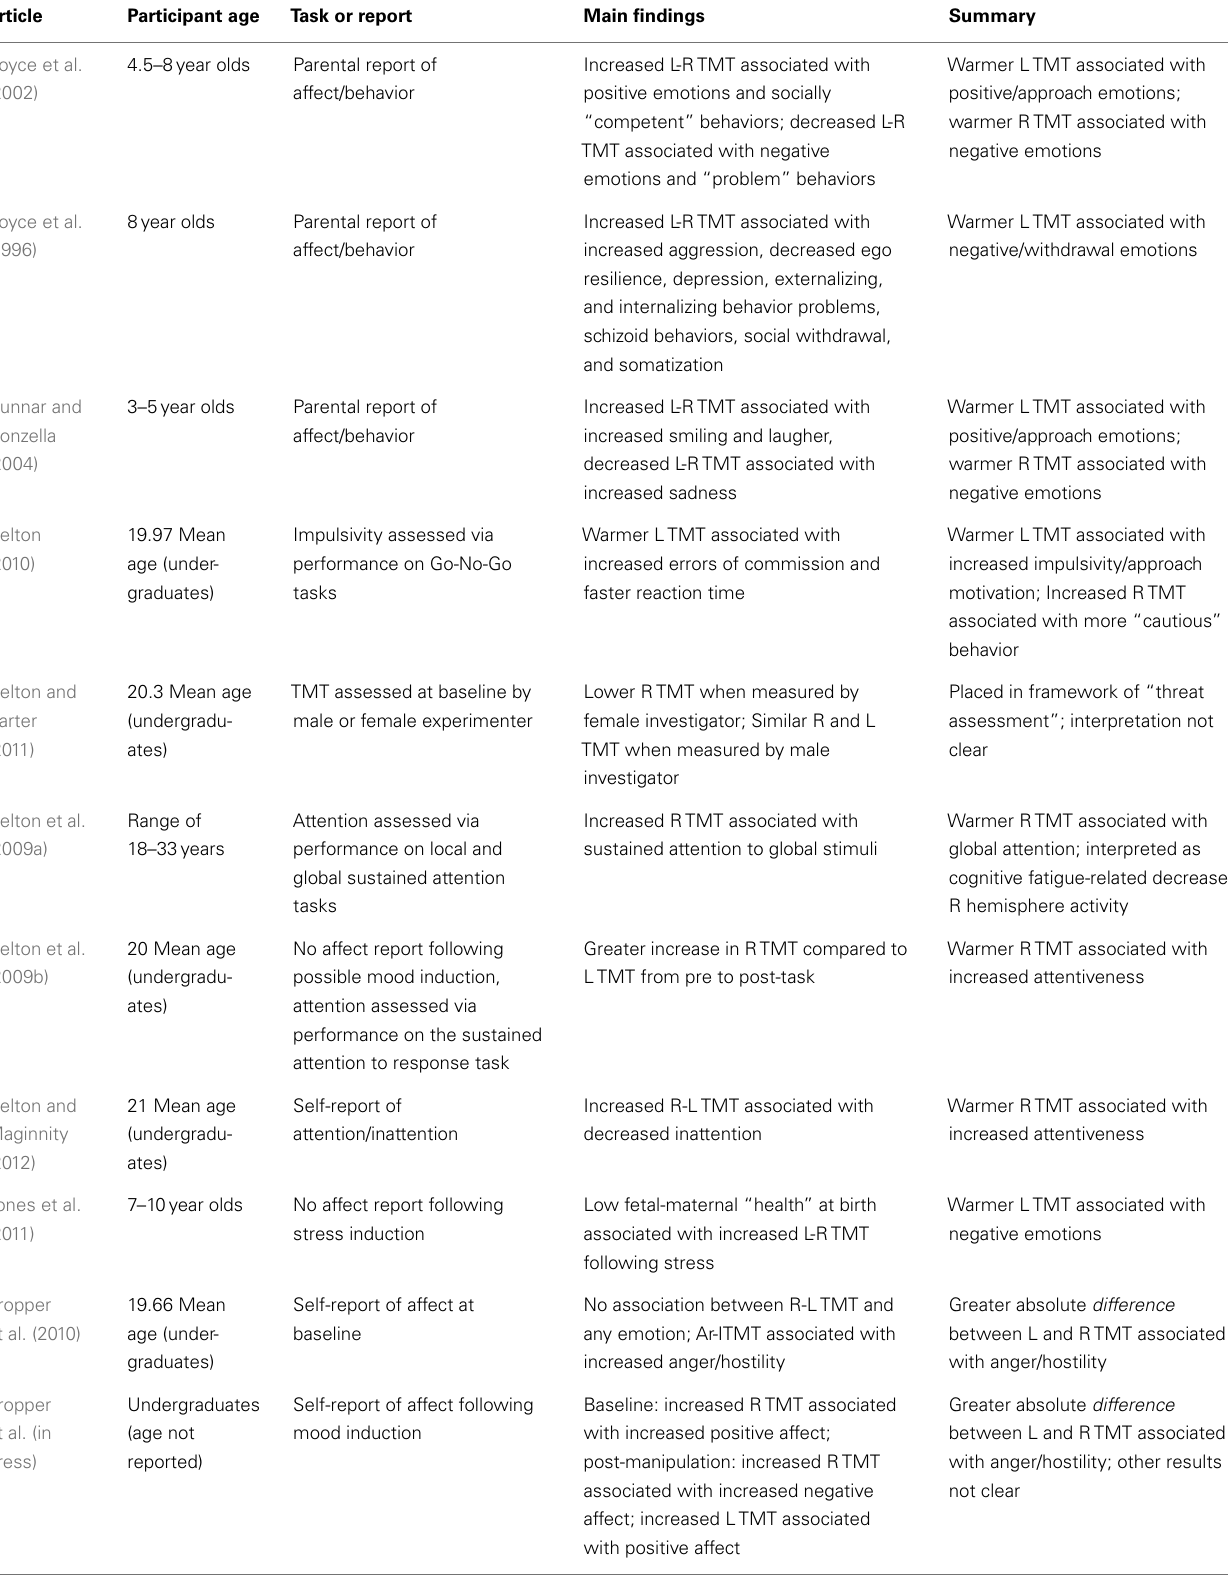
Table 1 |Tympanic membrane temperature and affect/motivational orientation